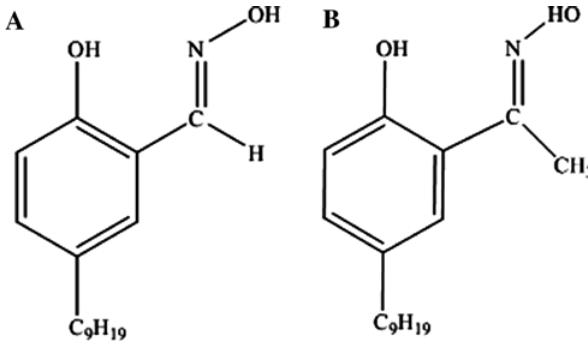
Figure 1: The structural formula of the main chemical composi- tion of LIX984N: (A) 5-nonyl salicylaldoxime, (B) 2-hydroxy-5-nonyl acetophenone.